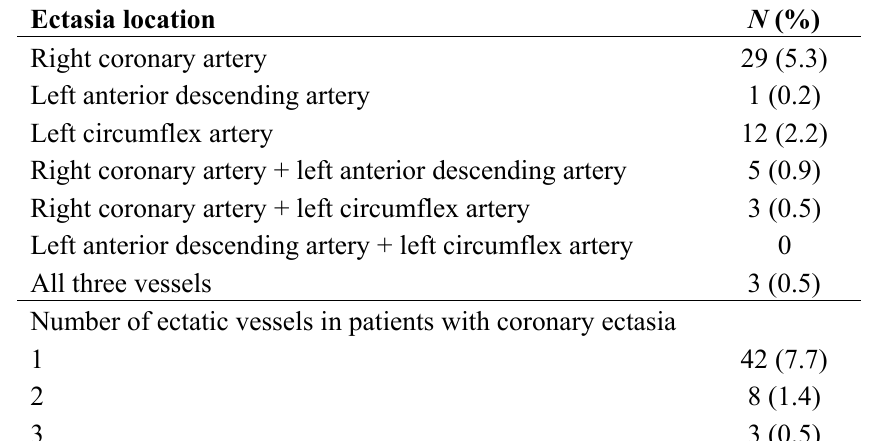
Table 2. Angiographic characteristics among the 53 coronary ectasia